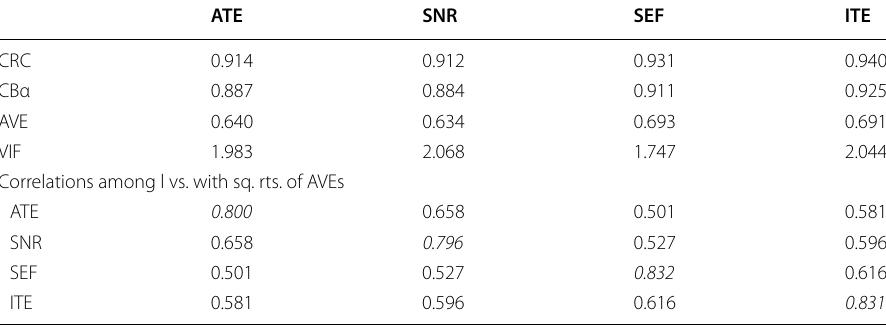
Italic items are square root of average variances extracted